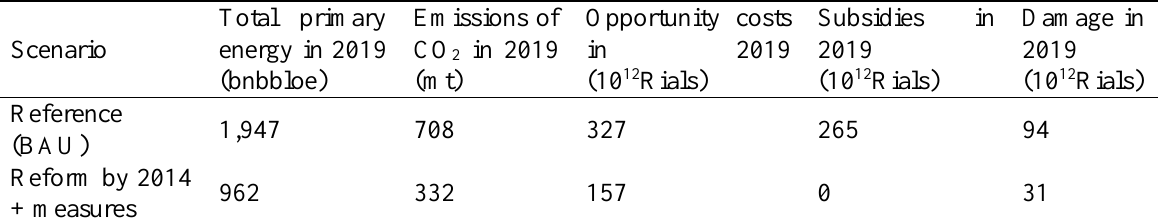
Table 7. Indicators for combined price reform and sectorial measures in 2019